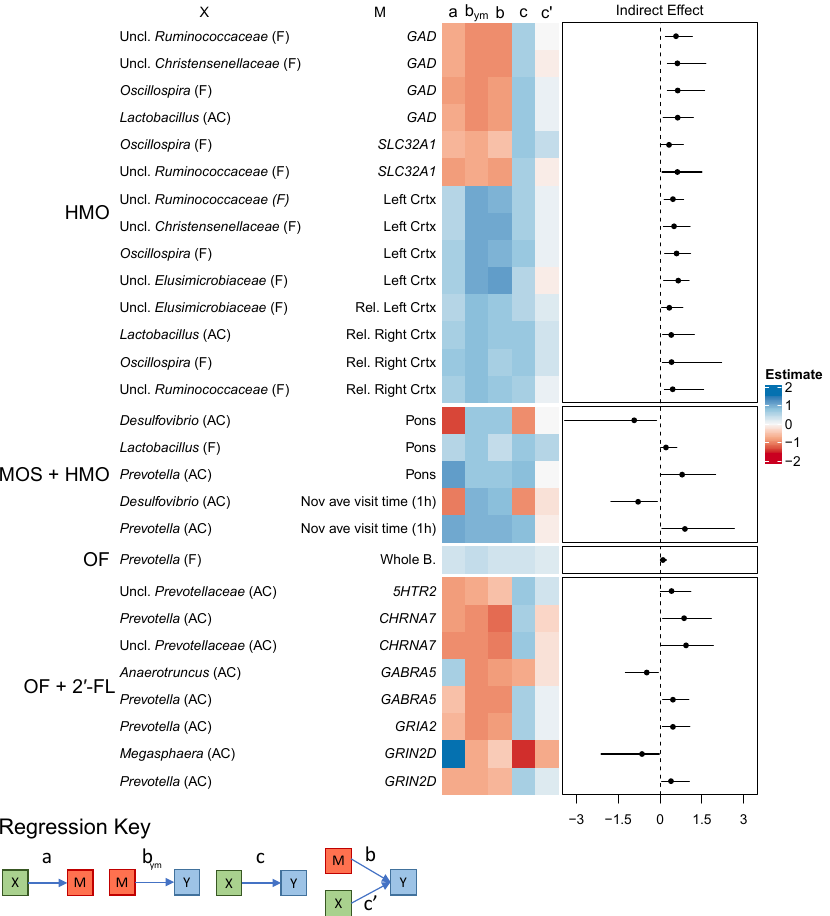
Figure 3. Heatmaps demonstrating the relationships between predictor (X), mediating (M), and predicted variables (Y, short-term recognition memory). Only mediations whose confidence intervals of the indirect effect do not include zero are shown. The right-most box represents the estimates of the indirect effect (c-c’) bounded by its lower and upper 95% confidence intervals. Paths a, b ym , b, c, and c’ are the regression coefficients for X → M, M → Y, X → Y, and X + M → Y,